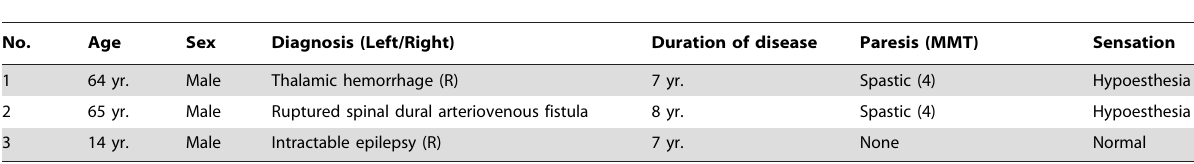
Table 1. Clinical profiles in patients who participated in this study.